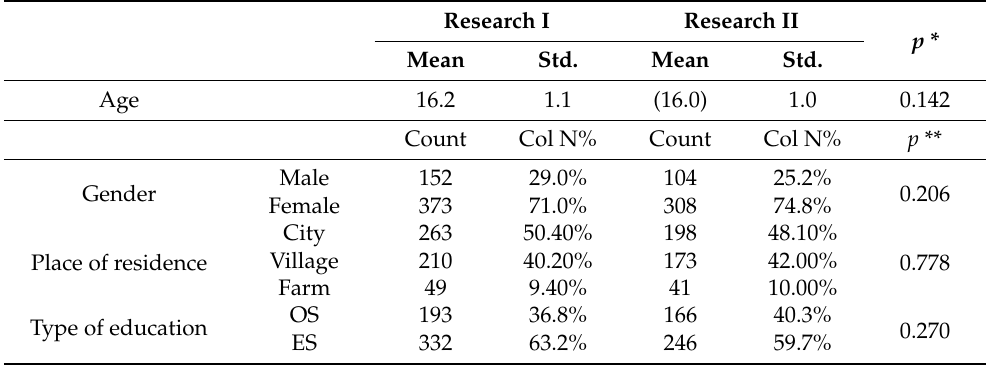
Table 1. Characteristics of the study